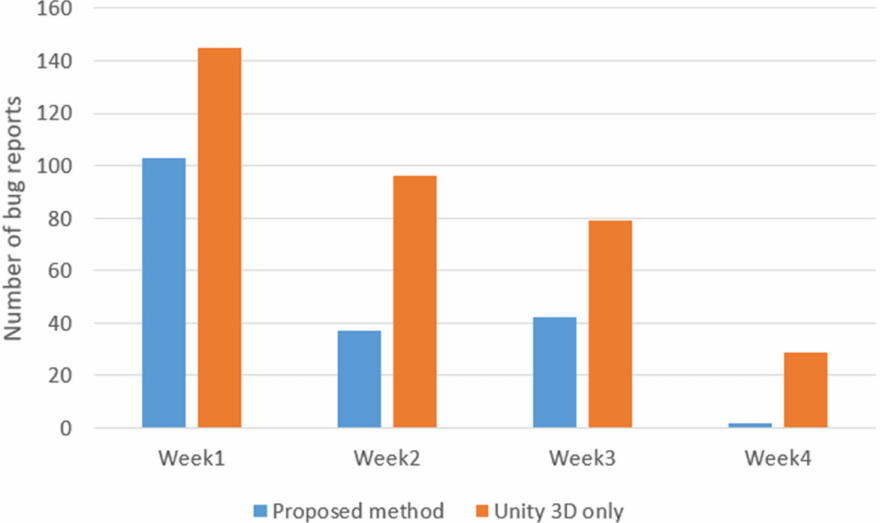
Figure 7. Comparison of the number of bug reports between Unity 3D and the proposed